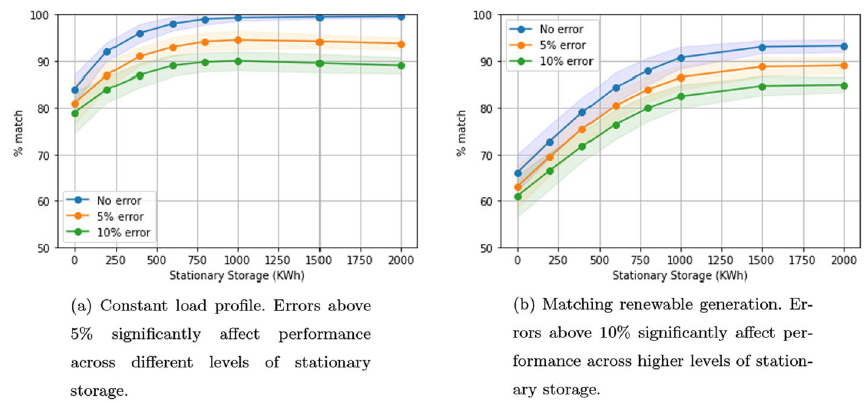
Fig. 10 Impact of errors in estimating building load. One-way charging in a residential